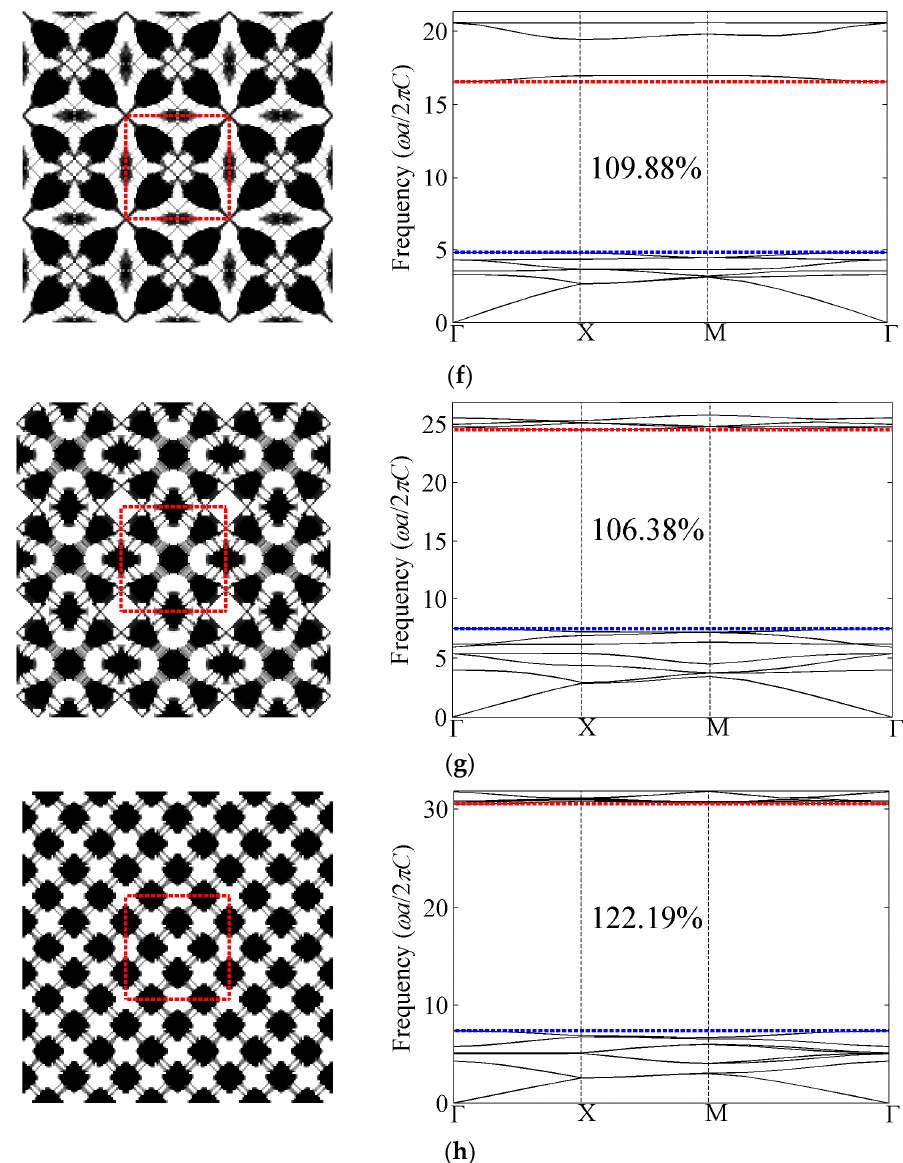
Figure 8. Optimized topologies and corresponding band structures for out-of-plane mode with shear modulus constraint. ( a ) The first band gap; ( b ) the second band gap; ( c ) the third band gap; ( d ) the fourth band gap; ( e ) the fifth band gap; ( f ) the sixth band gap; ( g ) the seventh band gap; and ( h ) the eighth band gap.